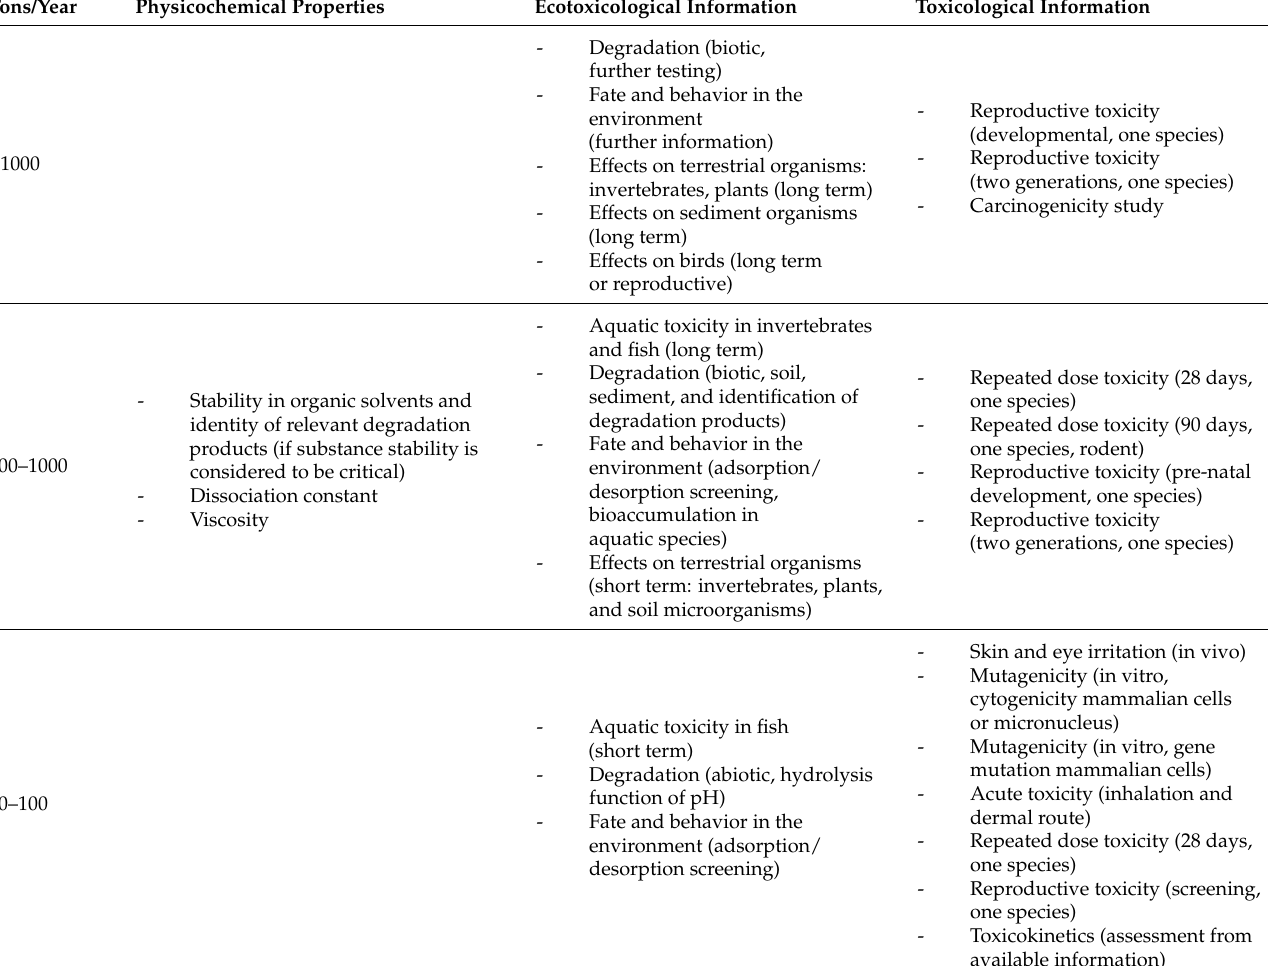
Table 1. Physicochemical properties and ecotoxicological and toxicological information proposed by REACH to classify a